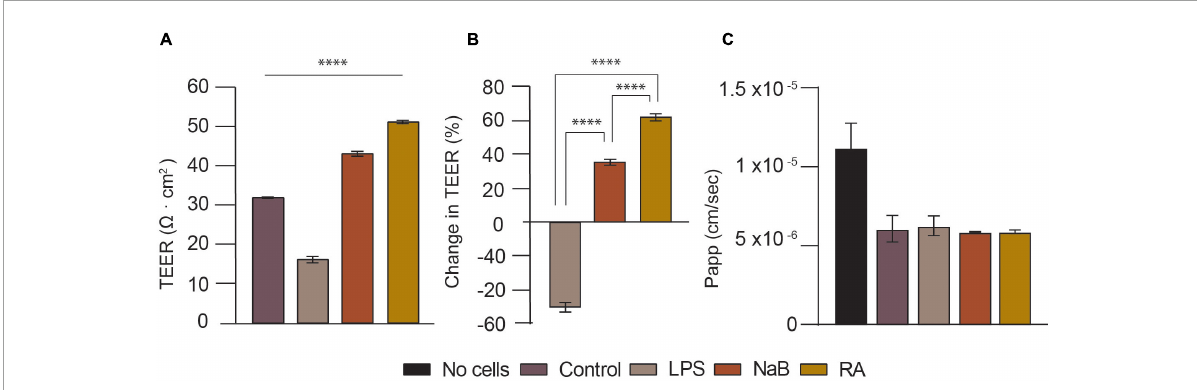
FIGURE5 Validation of the tri-culture neurovascular unit (NVU) model by characterizing BBB permeability upon treatment with LPS, NaB, or RA for 24 h. (A) Transendothelial electrical resistance (TEER) measurements ( (cid:127) cm 2 ) for NVU tri-culture setups used for BBB integrity evaluation: control (i.e., no treatment), LPS, NaB, and RA treated samples on day 14. The difference between the control and samples was analyzed using one-way ANOVA, with ∗∗∗∗ p < 0.0001 (Dunnett’s multiple comparison test). Error bars represent the standard deviation of three replicates for each condition (mean ± SD, n = 3). (B) Bar Chart showing the change in TEER (%) estimated for each treated tri-culture sample. The difference in % between treated samples was analyzed using one-way ANOVA, with ∗∗∗∗ p < 0.0001 (Tukey’s multiple comparison test). Error bars represent the standard deviation of three replicates for each condition (mean ± SD, n = 3). (C) Lucifer yellow (LY) flux and apparent permeability (Papp) bar charts for each tri-culture treated